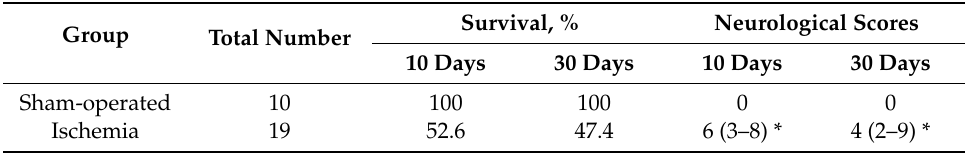
Table 1. Animal survival and neurological scores after surgery 1